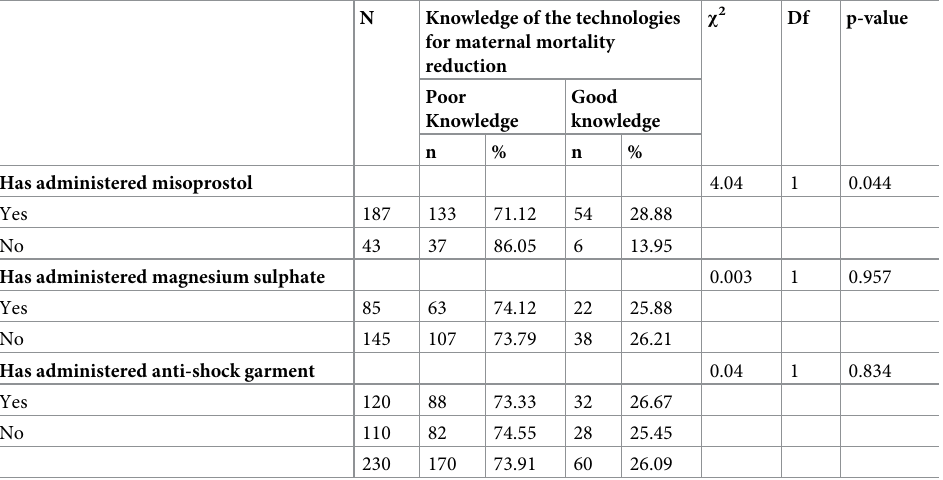
Table 6. Factors associated with knowledge of the technologies for maternal mortality reduction and the utiliza- tion of the technologies (Misoprostol, MgSO 4 and